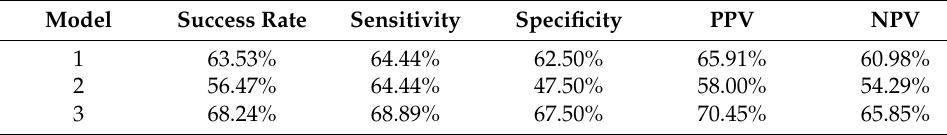
Table 2. Model comparison based on the ability to classify subjects.